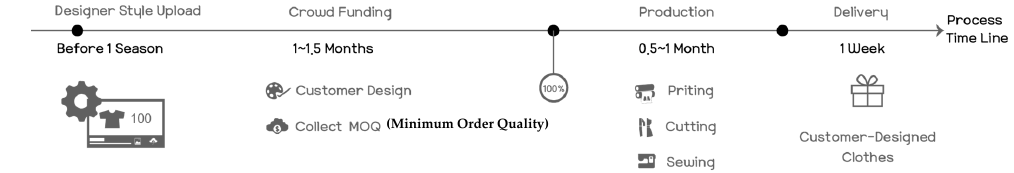
Figure 22. Crowdfunding process of customer design participation.